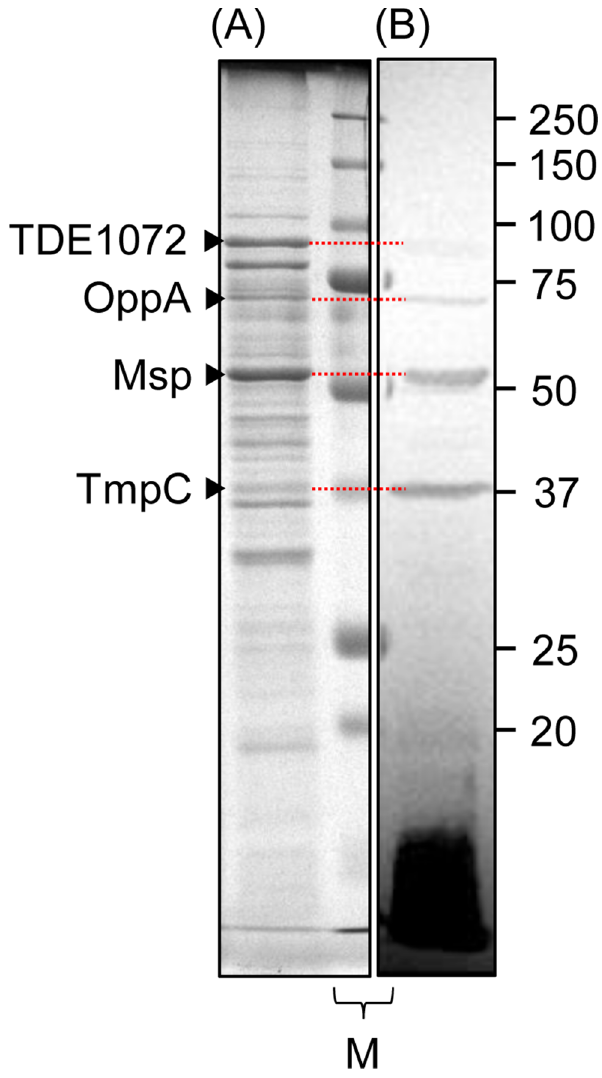
Figure 1. Identification of major antigenic proteins in T . denticola . The envelope fraction of the wild type of T . denticola was applied to two lanes across a molecular-weight standard in an SDS- PAGE gel (11%), and the gel was divided after electrophoresis. One fraction was stained with CBB (A) and the other was subjected to western blot analysis using anti- T . denticola antiserum (previously prepared by the authors [8]) (B). The western blot analysis showed two strong positive bands at 53 and 37 kDa, which were predicted to be Msp and TmpC, respectively, by mass spectrometry analysis of the corresponding bands in the CBB-stained gel. The two weak bands (at 91 and 70 kDa) were predicted to be TDE1072 and OppA, respectively. M shows a split band of a molecular-weight standard. The approximate size of each polypeptide is indicated at the right (kDa).